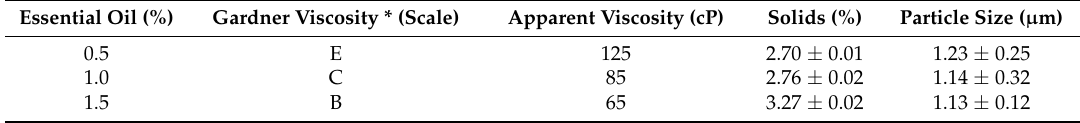
Table 2. Physical properties of the CT-TCEO